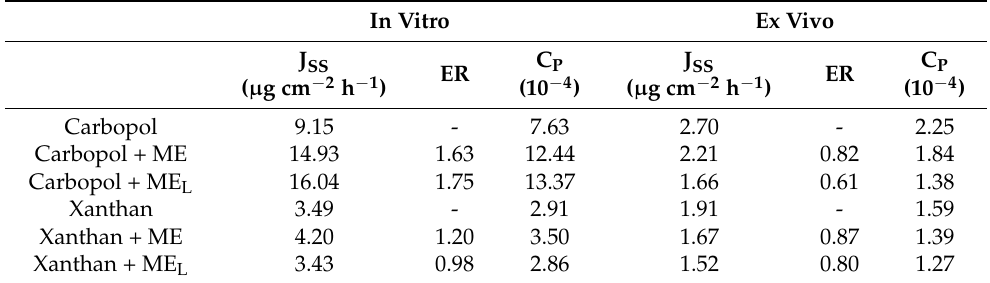
Table 4. Steady-state flux (J SS ), permeability coefficient (C P ), and enhancement ratio (ER) comparing the microemulsion gel formulation to the reference gel under the in vitro and ex vivo conditions.